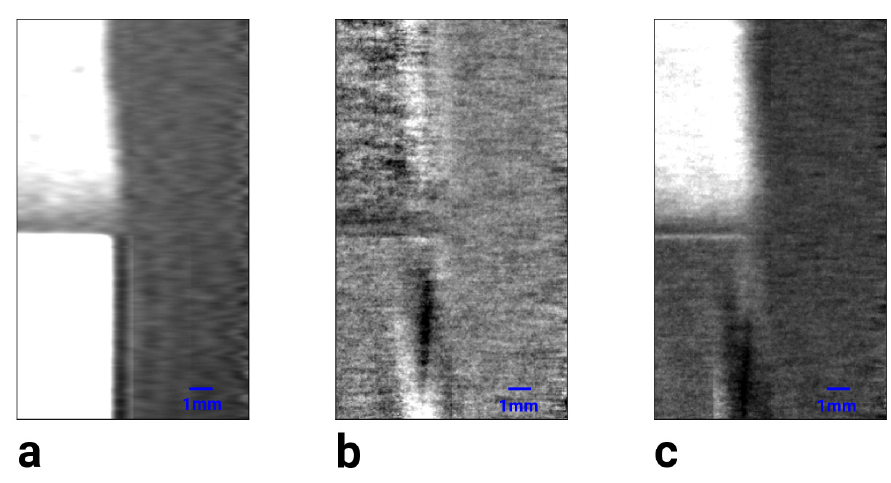
Figure 4. Attenuation ( a ), differential phase-contrast ( b ) and dark-field ( c ) image of the phantom’s sponge ( top ) and the PMMA step-wedge ( bottom ). Ringing artifacts can be observed at the edges of the wedge. The images correspond to the green area in Figure